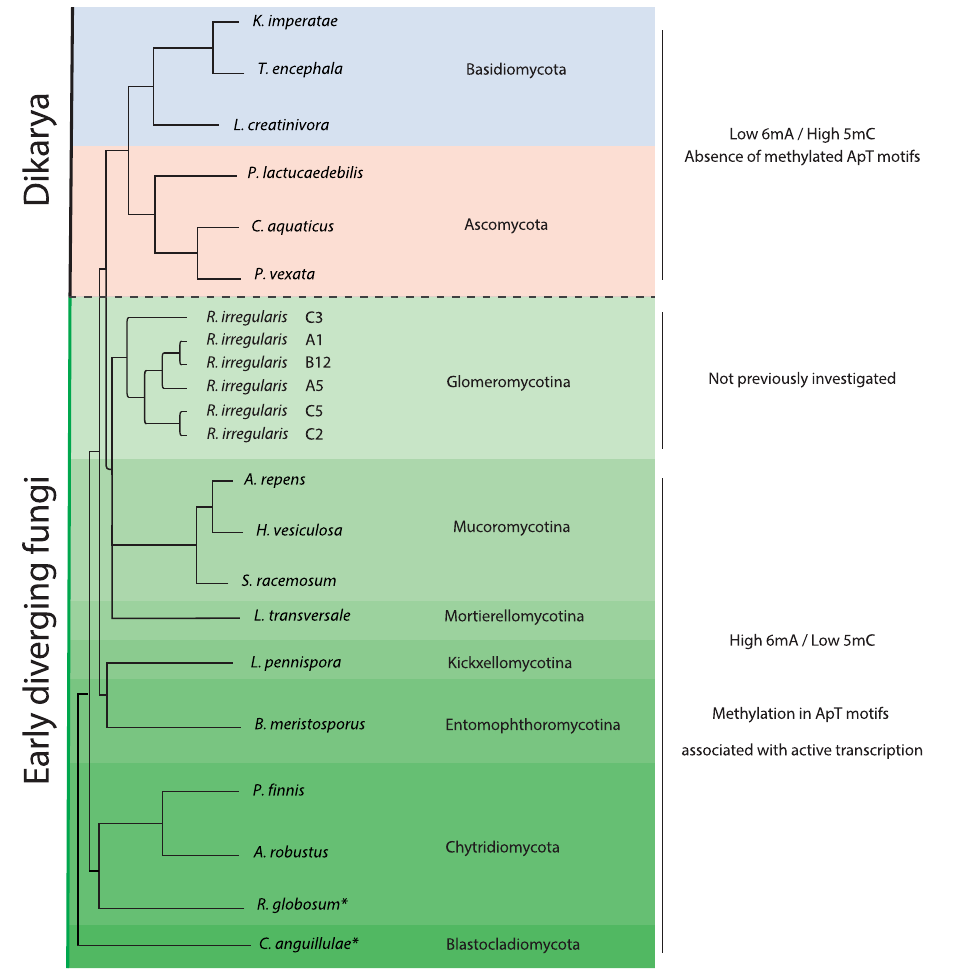
Fig. 1 Previously investigated 6mA and 5mC contents throughout the fungal phylogeny. A phylogeny of the fungal kingdom showing that there was a shift in the functional methylome during the divergence of EDF and Dikarya from high 6mA and low 5mC contents in EDF to to high 5mC and low 6mA contents in Dikarya. However, the arbuscular mycorrhizal fungi (Glomeromycotina) have not been previously investigated. *Represents species that do not follow the general pattern of methylation in EDF. In these species, 6mA is low and appears not to have the same functional signi fi cance as in EDF as it does not occur in ApT motifs, which are important for ensuring active gene